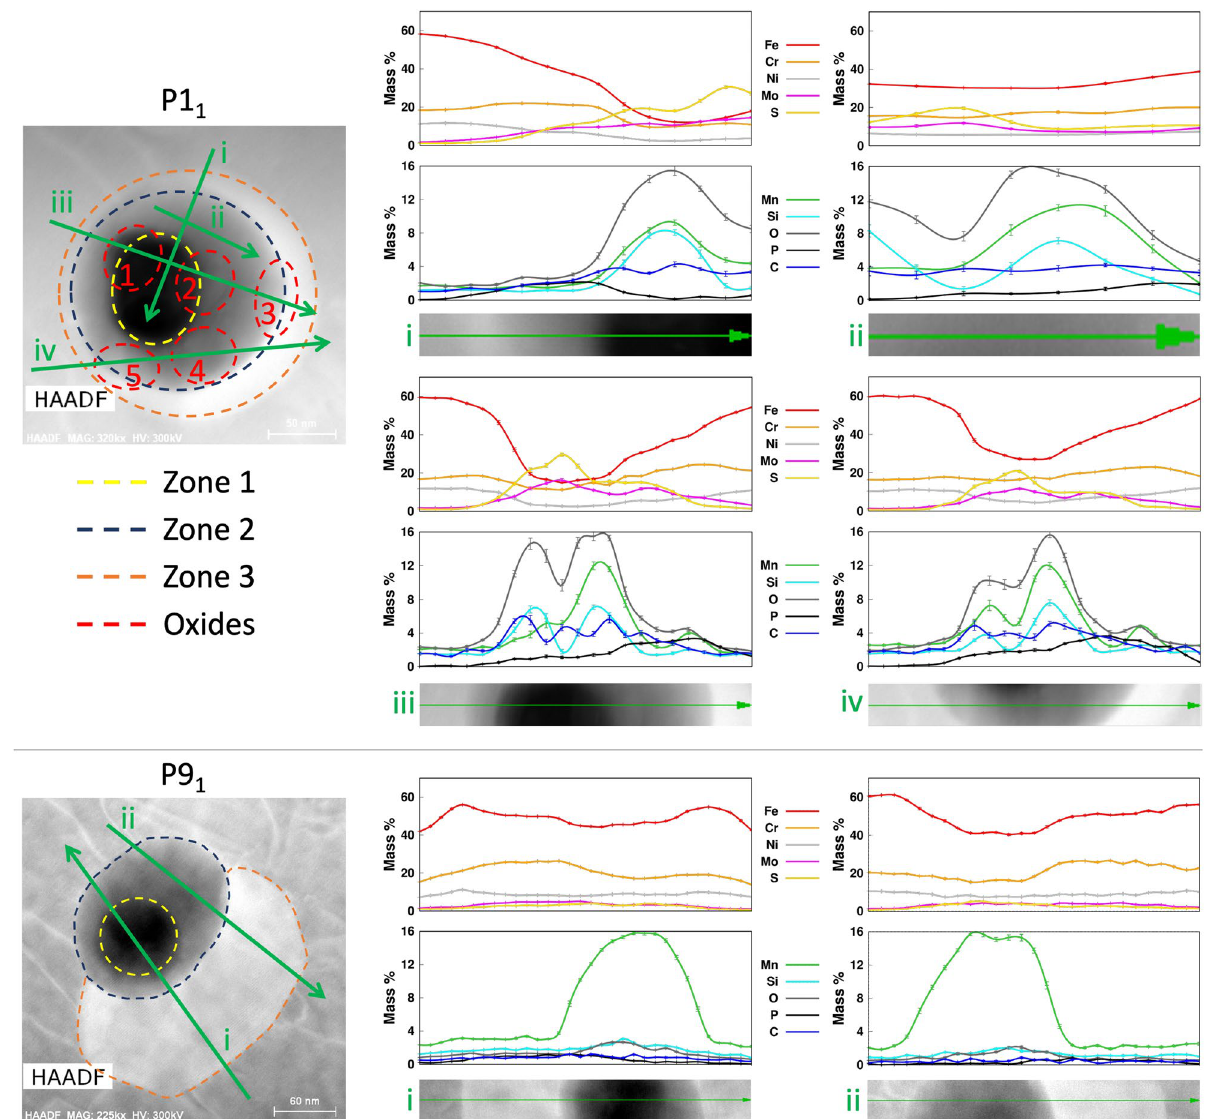
Figure 4. HAADF images and EDS line profiles for precipitates P1 1 and P9 1 along different paths. The points in the curves have been fitted using c-splines. The key for both HAADF images is presented below the HAADF image of P1 1 . HAADF images have been acquired using the TIA v4.2 (FEI https:// www. fei. com) software. Fiji v2.1.0/1.53c (https:// fiji. sc), gnuplot v5.4 (http:// www. gnupl ot. info) and Microsoft PowerPoint have been used to prepare this